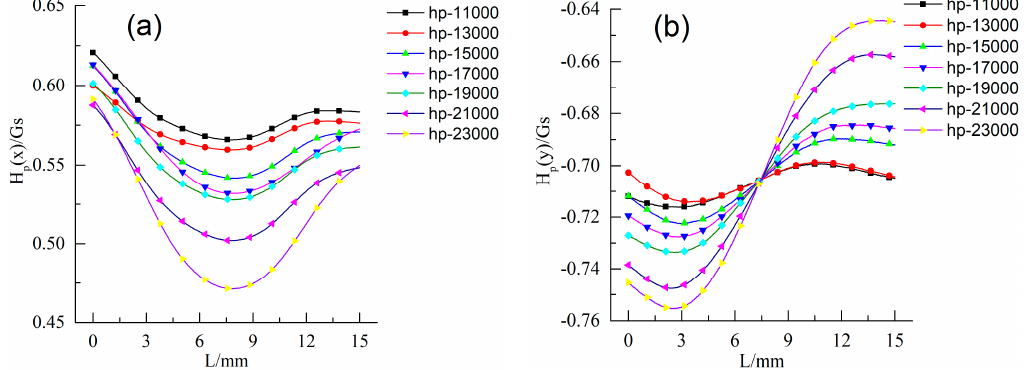
p (x); and ( b ) H p (y).